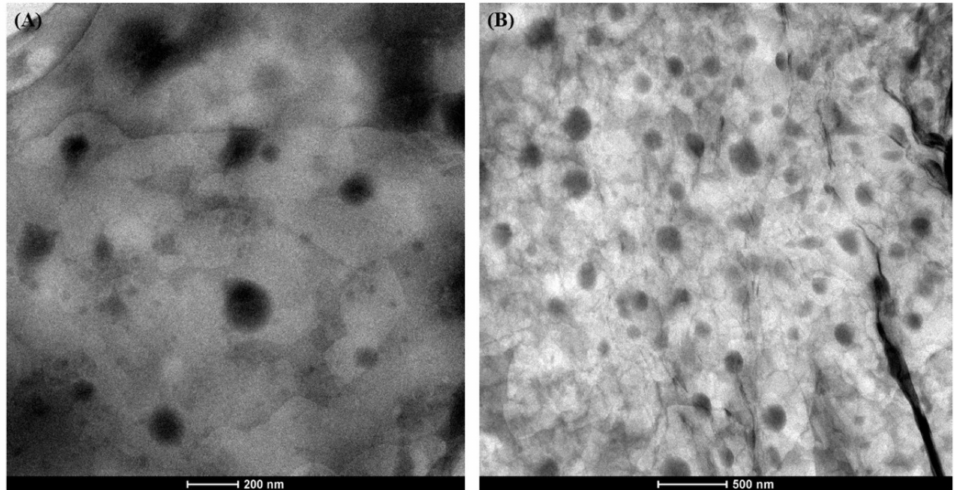
Figure 5. TEM images of F9 formulation. Scale bar represents ( A ) 200 nm and ( B ) 500